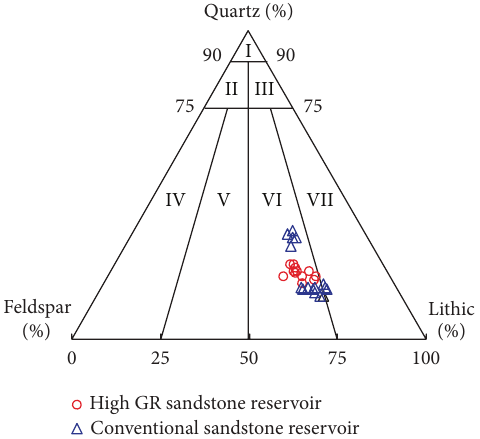
Figure 1: The lithology chart: I quartz sandstone, II feldspar quartz sandstone, III lithic quartz sandstone, IV feldspar sandstone, V lithic feldspar sandstone, VI feldspar lithic sandstone, and VII lithic sandstone.